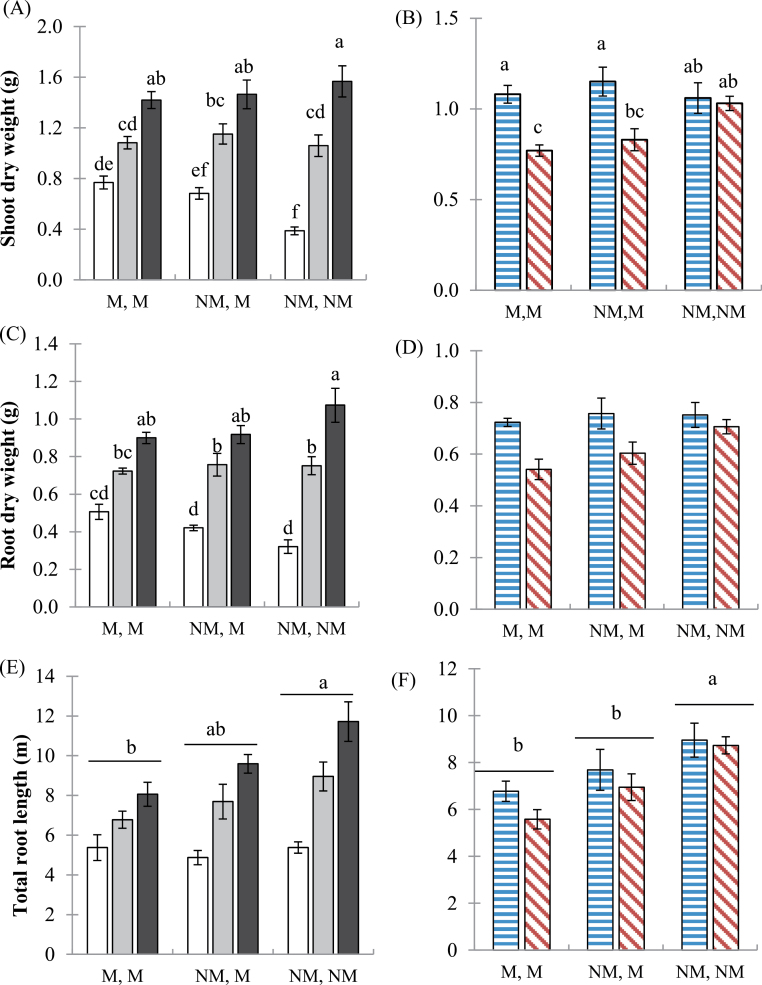
Effects of soil P level and AM colonization on plant growth. Shoot and root dry weights and total root length (pot A and pot B) of (A, C, E) the wild-type genotype at three soil P additions: 0 (white bars), 20 (grey bars), and 50 (black bars) mg P kg–1, and (B, D, F) the wild type (horizontal bars) and mtpt4 mutant (diagonal bars) at P20 only. Values are the mean ±standard error, n=5. Means followed by the same letter were not significantly different at the P<0.05 level. (This figure is available in colour at JXB online.)